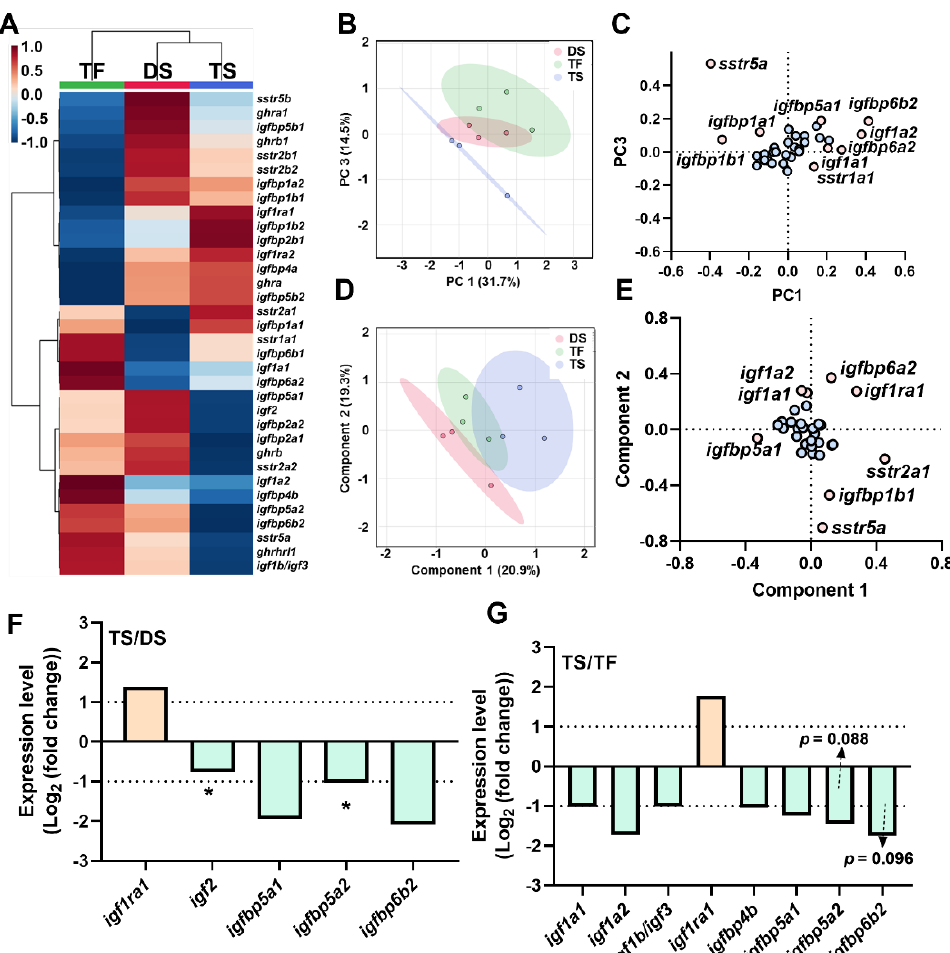
Figure 4. The transcriptional signature of ghrh-sst-gh-igf axis in liver in diploid and triploid trout. ( A ) The heatmap of ghrh-sst-gh-igf axis in brain. ( B , C ) Principal component analysis ( B ) and loading plot ( C ) of ghrh-sst-gh-igf axis. ( D , E ) Partial least squares discriminant analysis ( D ) and loading plot ( E ) of ghrh-sst-gh-igf axis. In loading plot, gene(s) further away from center point (0, 0) showed obvious effects on principal component analysis/partial least squares-discriminant analysis. ( F , G ) Key genes of ghrh-sst-gh-igf axis of TS/DS ( F ) and TS/TF( G ). Genes were selected based on the principle of Log 2 |Foldchange| ≥ 1 or p value < 0.05 (Log 10 (count+1) by Student’s t -test, “*” p < 0.05). TS: t riploid s eawater exposure; DS: d iploid s eawater exposure group; TF: t riploid f reshwater exposure group.